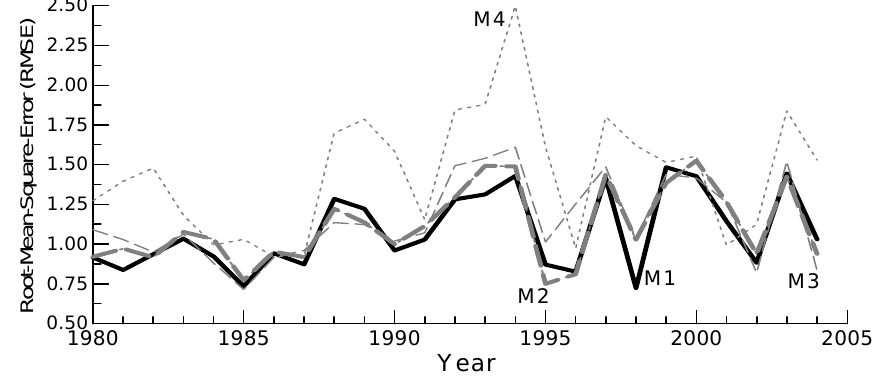
Fig. 2. As same as in Fig. 1 but for